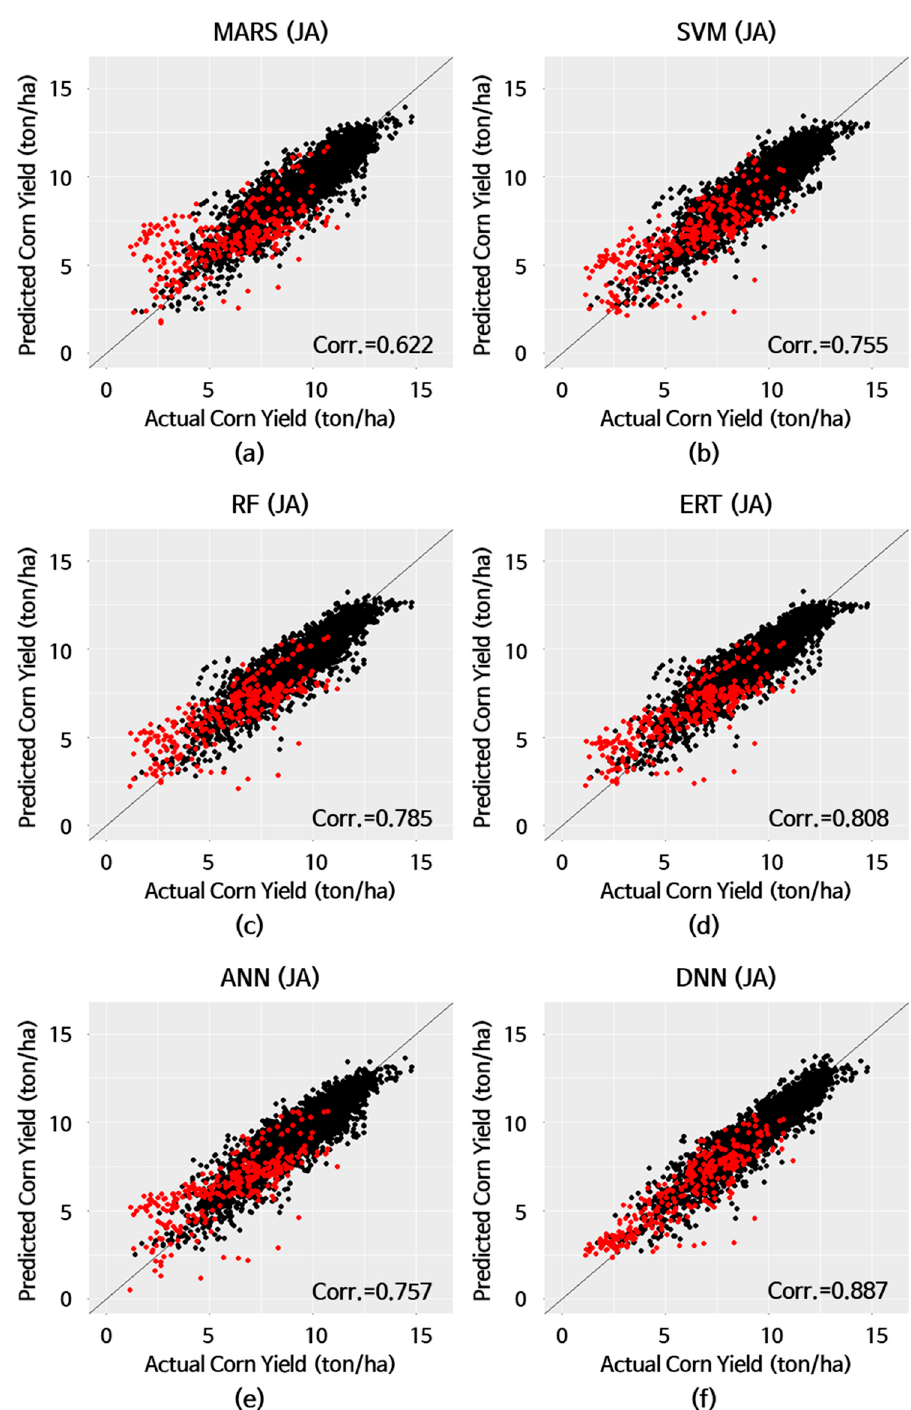
Figure 9. Actual and predicted corn yields from the leave-one-year-out blind tests for 2006–2015: Red dots, heatwave exceeding seven days; black dots, all other cases. ( a ) Multivariate adaptive regression spline (MARS); ( b ) Support vector machine (SVM); ( c ) Random forest (RF); ( d ) Extremely randomized tree (ERT); ( e ) Artificial neural network (ANN); ( f ) Deep neural network (DNN).